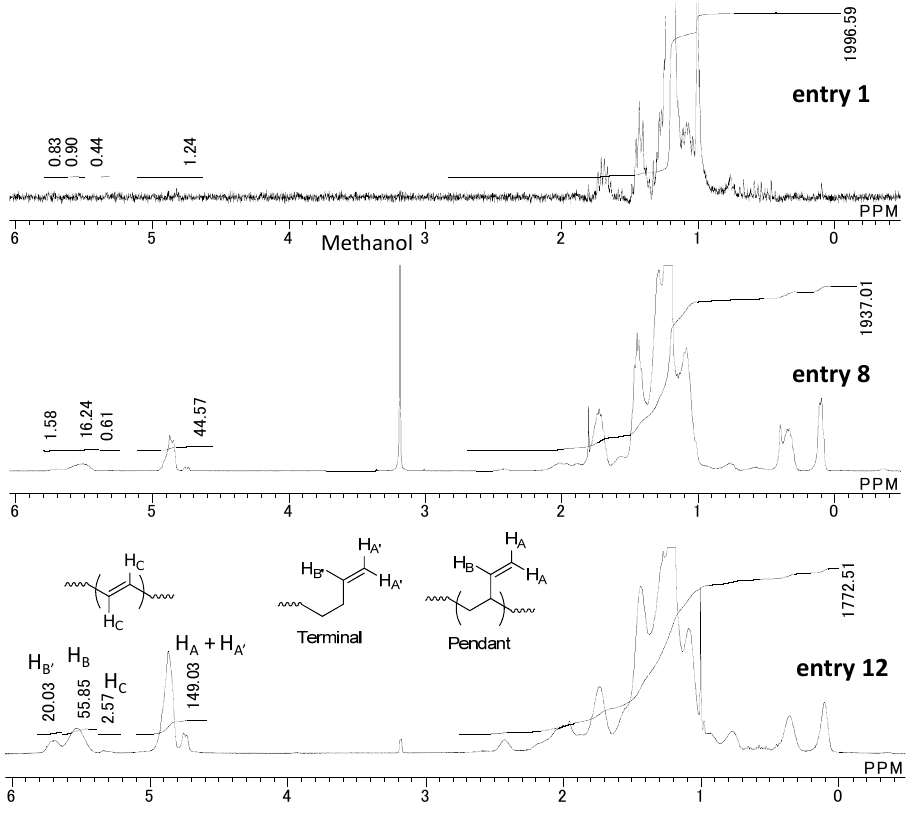
Figure 4. 1 H-NMR spectra of the ethylene/butadiene copolymers obtained from entries 1 , 8 , and 12 of Table